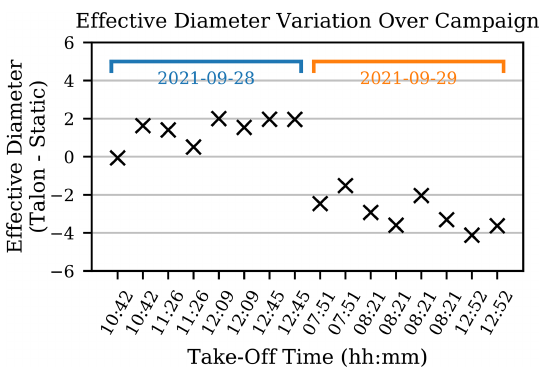
Figure 14. A correlation plot of the absolute difference in measured number concentration between the FMI-Talon and Static UCASS units, and airspeed, for 28 September. The linear regression line and “ p ” value are shown.